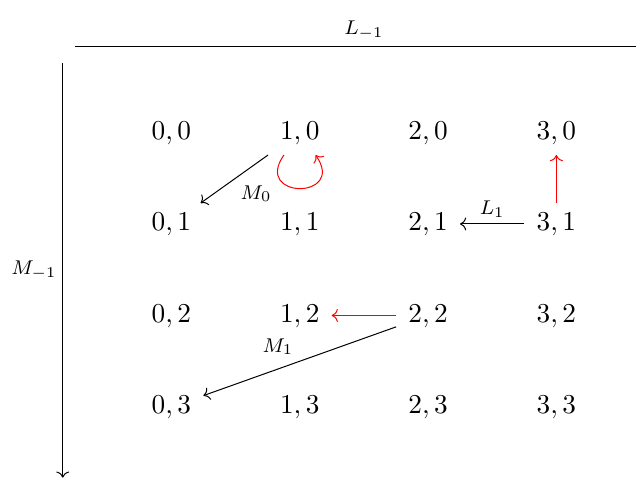
Table 1 . The action on the descendant states in singlet representation. The site ( n, m ) stands for the descendant | n, m i , and when ξ = 0 the three red arrows